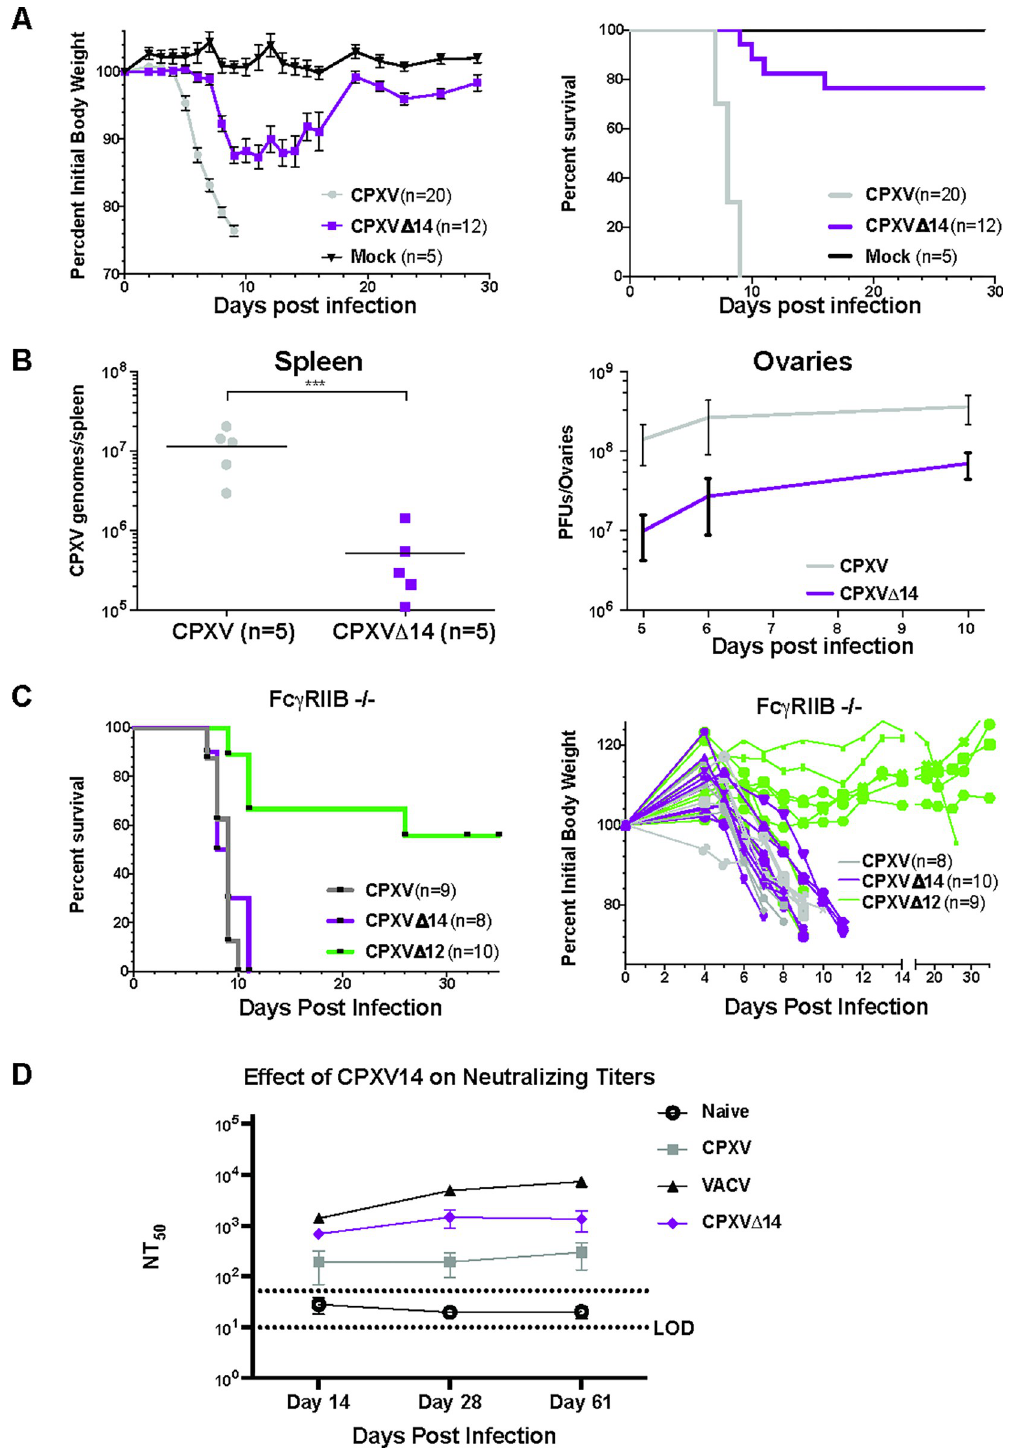
Fig 8. CPXV14 is a Fc γ RIIB-dependent virulence factor. A) Mice recover from lethal CPXV-infection in the absence of CPXV14. 11 week old female C57BL/6J mice were intranasally challenged with 2 x 10 5 PFU of the indicated viruses or mock- injected and monitored for weight loss (left). Animals were sacrificed when weight loss exceeded 20%. Differences in survival curves (right) between CPXV and CPXV Δ 14 were statistically significant (P < 0.0001) using Log-Rank (Mantel-Cox) test. The difference in mean weights of CPXV- and CPXV Δ 14-infected mice were shown to be statistically significant on day 6 post-